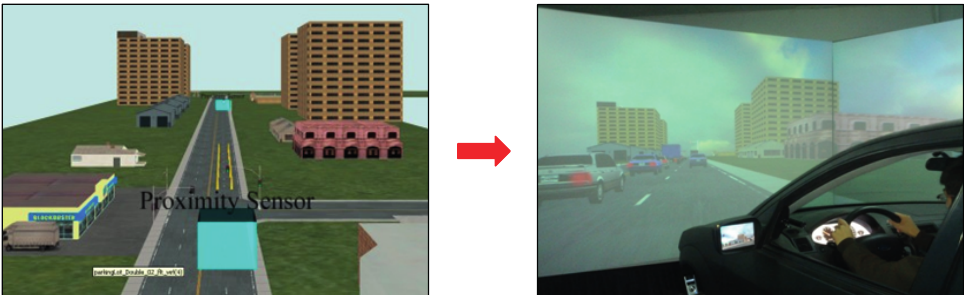
Figure 3: The design of traffic congestion and driving